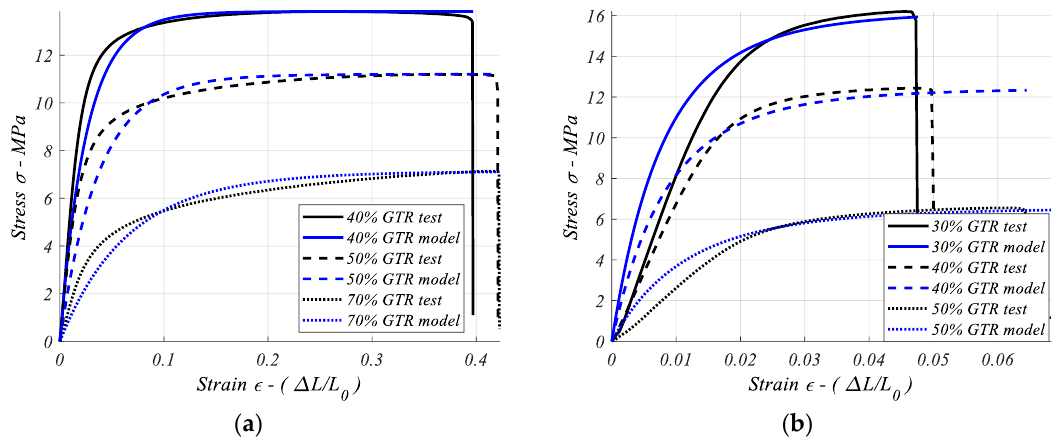
Figure 3. 𝜎 − 𝜀 curve test vs model, for GTR concentrations over 40%. ( a ) PP, ( b ) ABS.